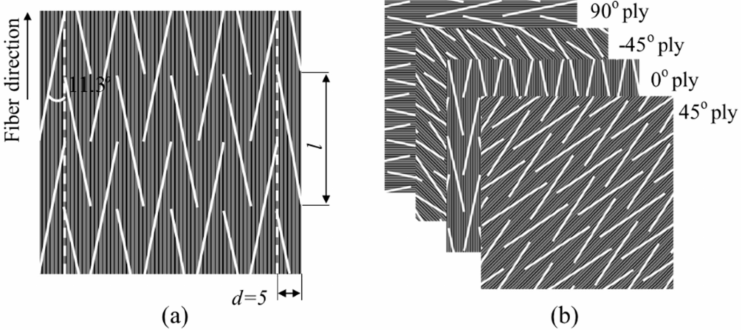
Figure 3. Slits and unidirectionally arrayed chopped strands (UACS) laminate: ( a ) bi-angled slit pattern, ( b ) stacking